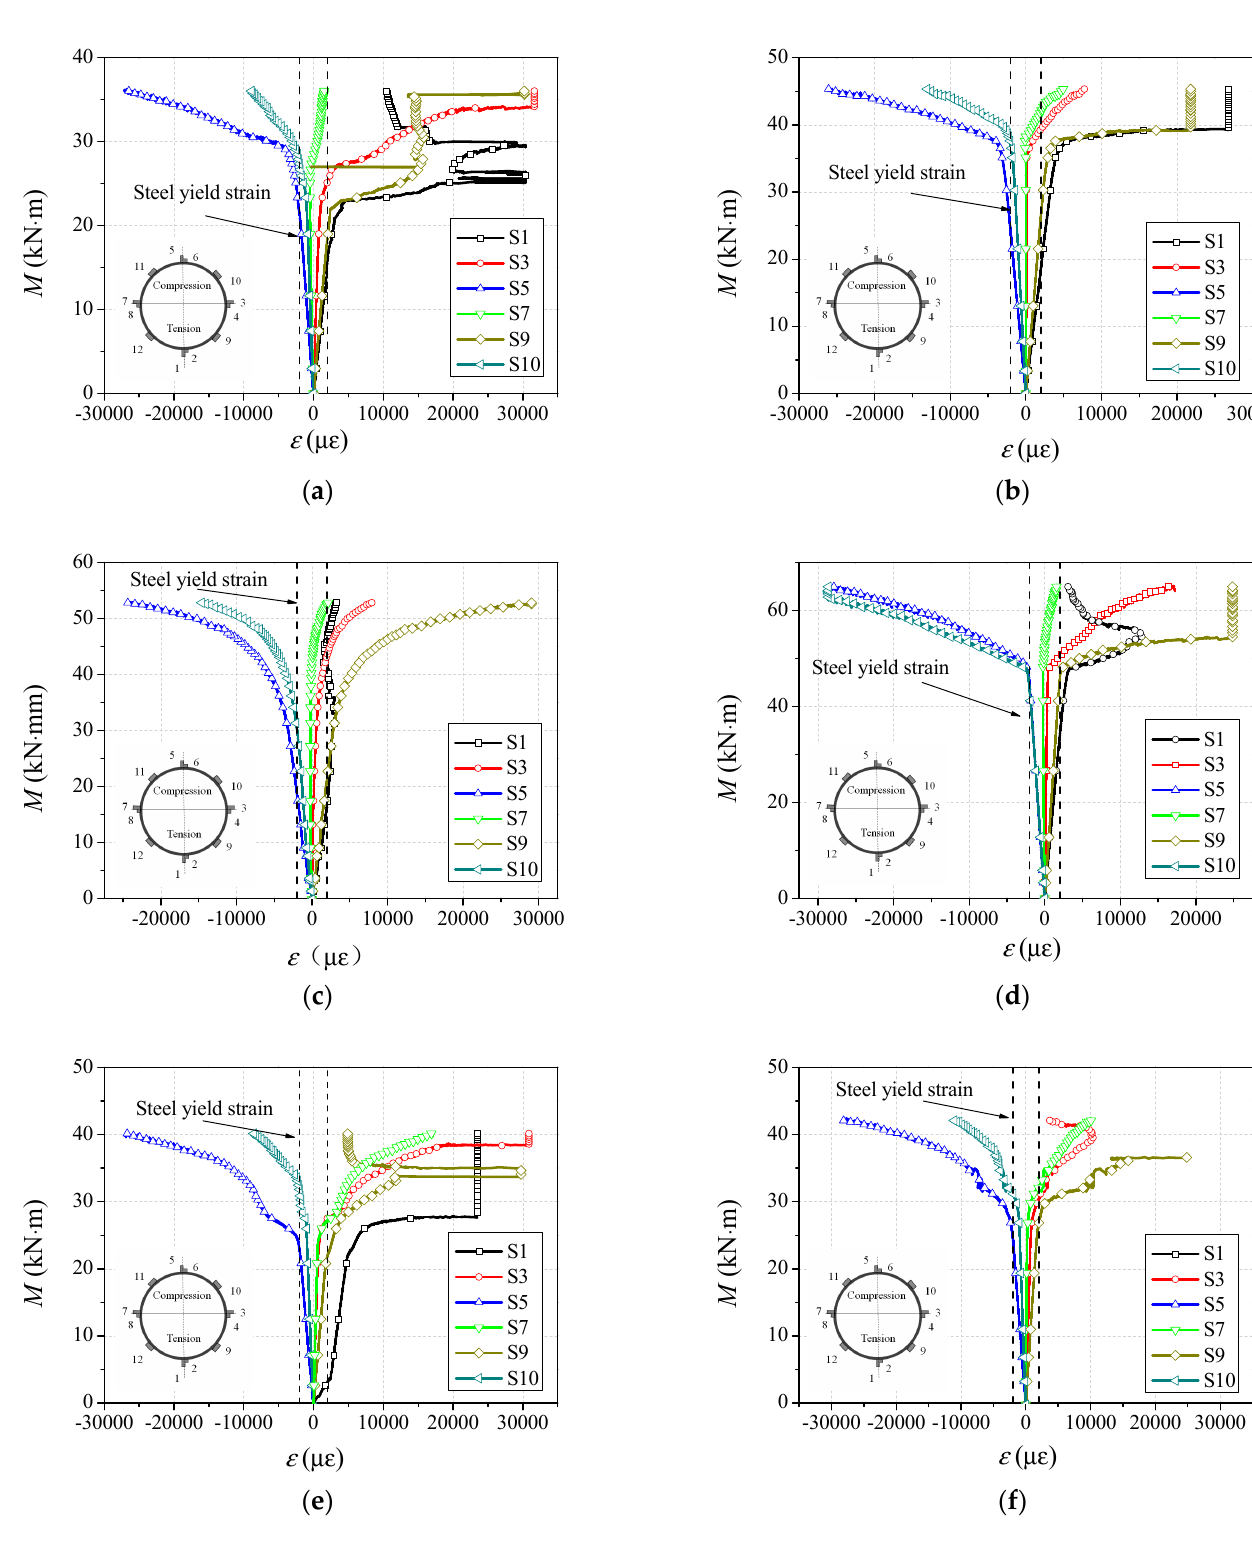
Figure 8. Moment-versus-strain curves of specimens. ( a ) BC32S4.5; ( b ) BC32S6; ( c ) BC32S8; ( d ) BC32S10; ( e ) BC30S6; ( f ) BC02S6.